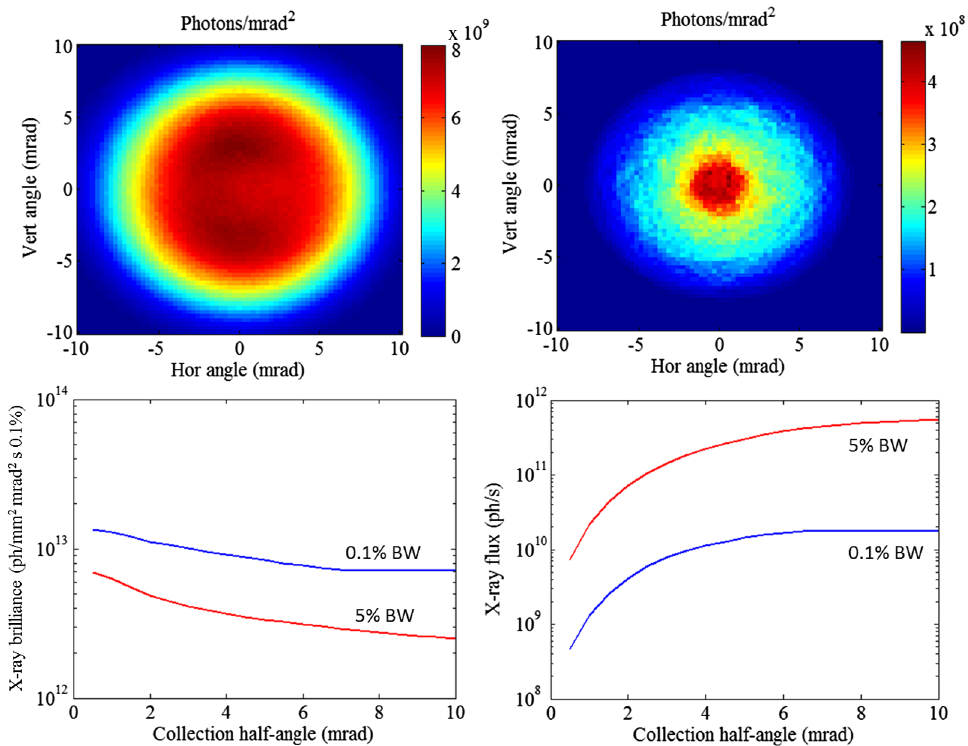
power.FIG. 5. Upper plots show x-ray intensity vs opening angle for 5% bandwidth (left) and 0.1% bandwidth (right) at 12 keV. Lower plots show brilliance (left) and flux (right) vs collection angle. The narrow bandwidth radiation has higher brilliance but lower flux. Flux for both cases is contained within a half angle of 5